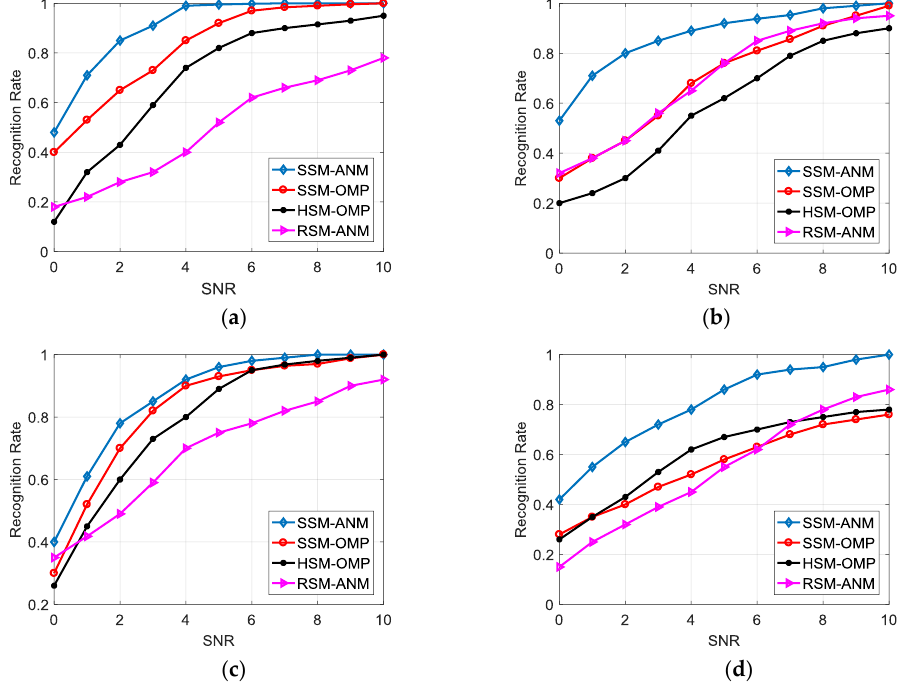
Figure 9. Recognition performance comparison in different SNRs (CPI = 20). ( a ) Type A; ( b ) Type B; ( c ) Type C; ( d ) Type D.